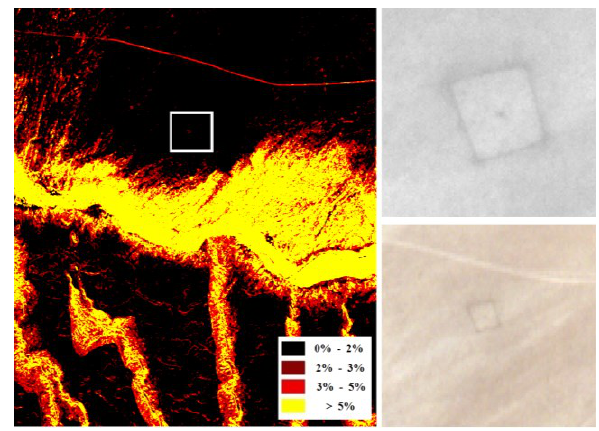
Figure 7. Spatial homogeneity map (CV%) of the Gobabeb calibration site as observed by SSOT multispectral bands (left) and subsets of the higher and lower resolution imagery